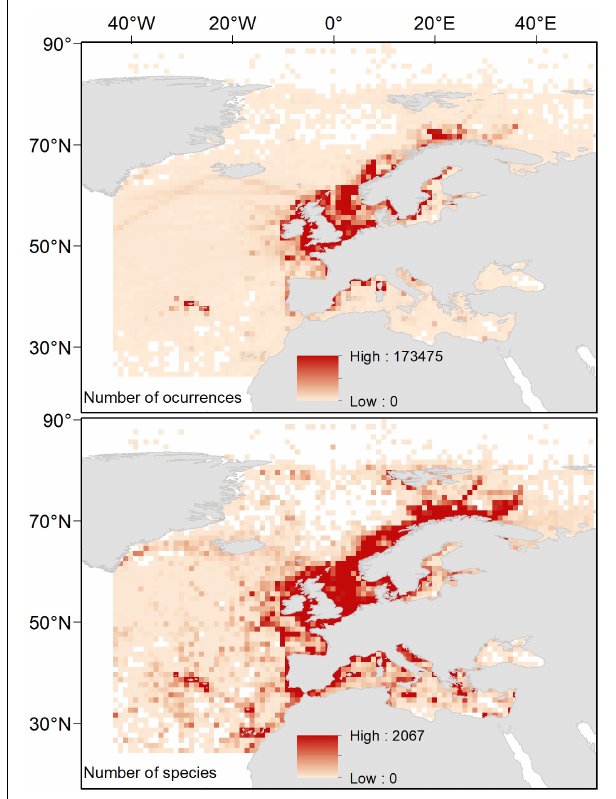
FIGURE 2 | Spatial distribution of total number of occurrences and total number of species per cell in a 1 ◦ × 1 ◦ grid